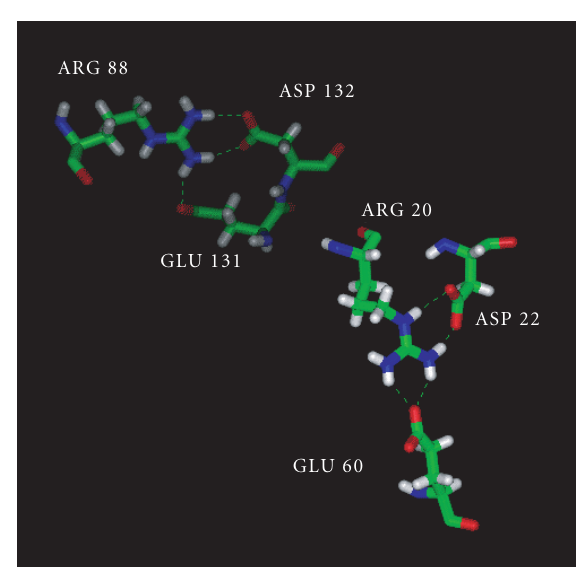
Figure 7: Salt bridges on the surface of cutinase. Amino acids in- volved in the formation of salt bridges on the surface of cutinase, as predicted by the pK a shifts using the program